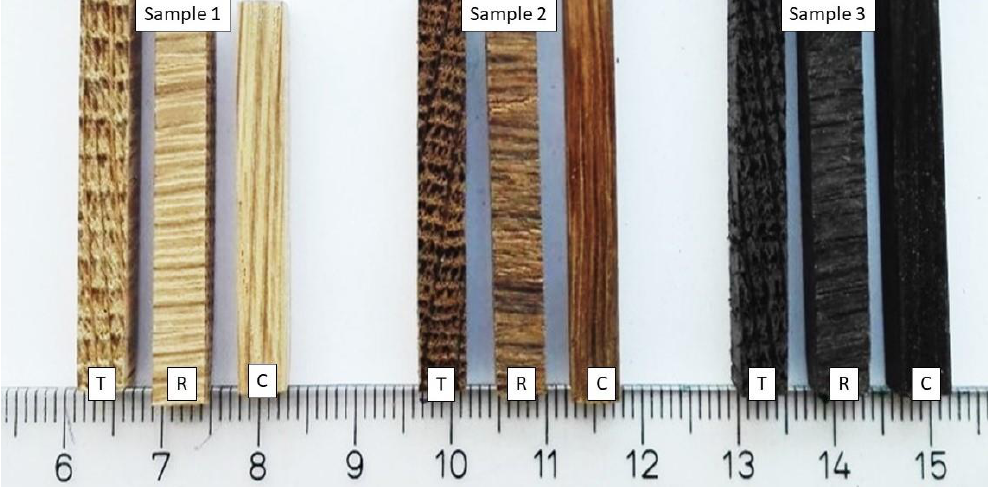
Figure 3. Test pieces prepared for testing .